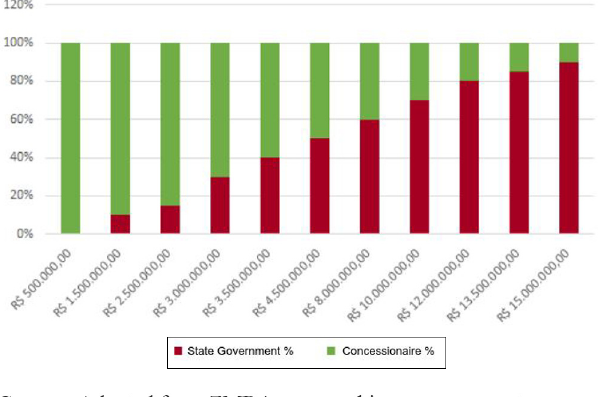
Figure 7. Tiers of tariff